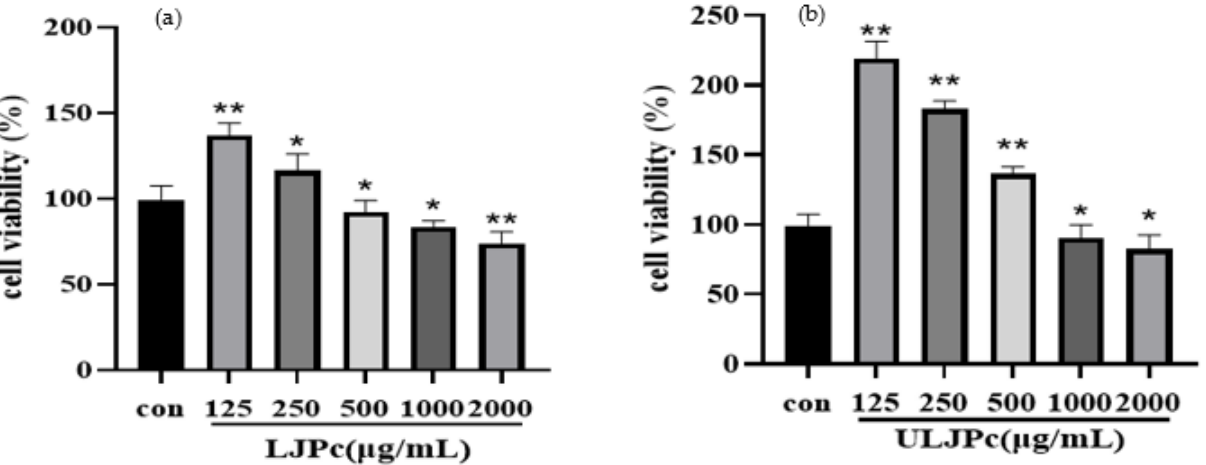
Figure 6. ( a ) Effects of LJP on the proliferation and viability of RAW264.7 macrophages; ( b ) Effects of ULJP on the proliferation and viability of RAW264.7 macrophages. (* p < 0.05; ** p < 0.01).